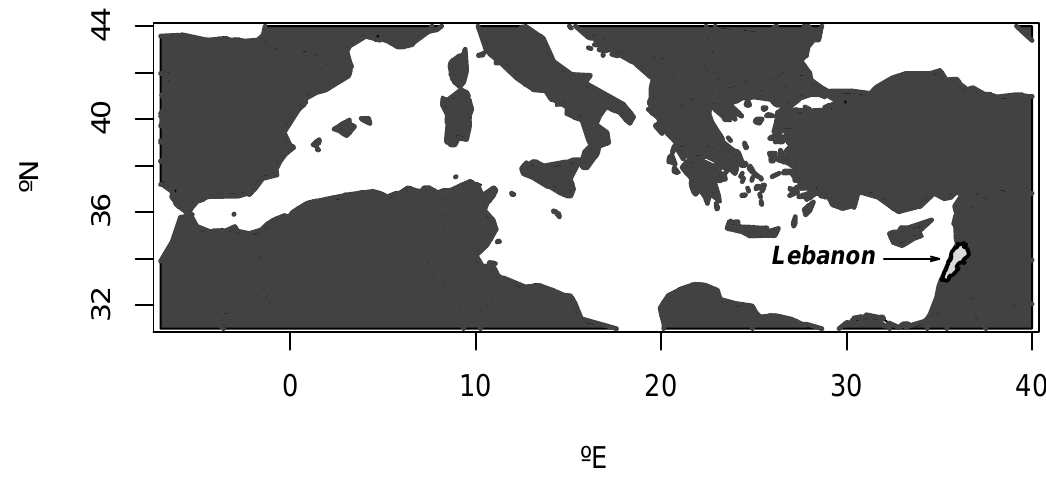
Figure 1. Lebanon, located in the eastern